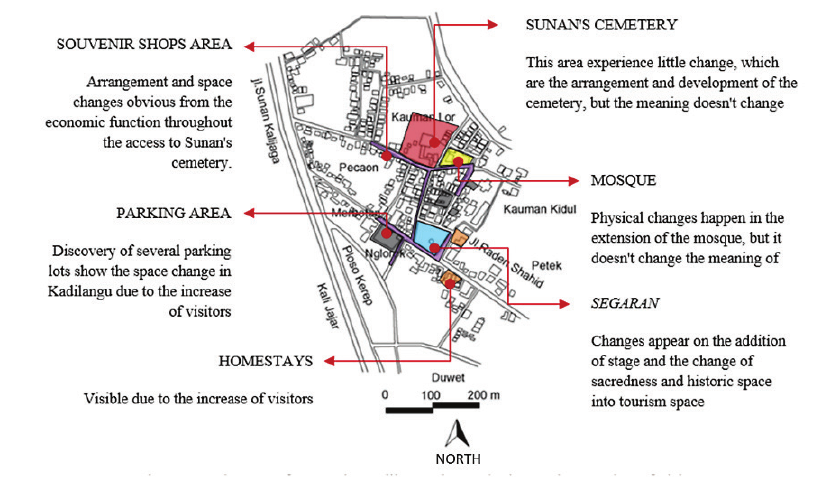
Figure 14. Changes of spaces in Kadilangu due to the increasing number of visitors (source: Survey,